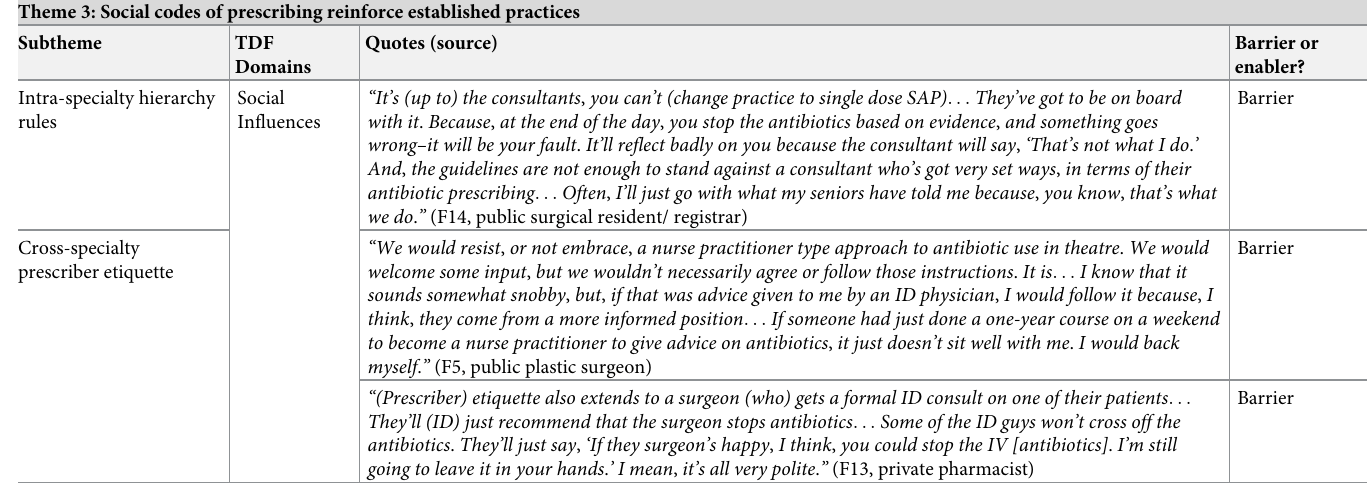
Table 5. Representative quotations from Theme 3, reflecting ‘Social Opportunity’ of the COM-B model. Theme 3: Social codes of prescribing reinforce established